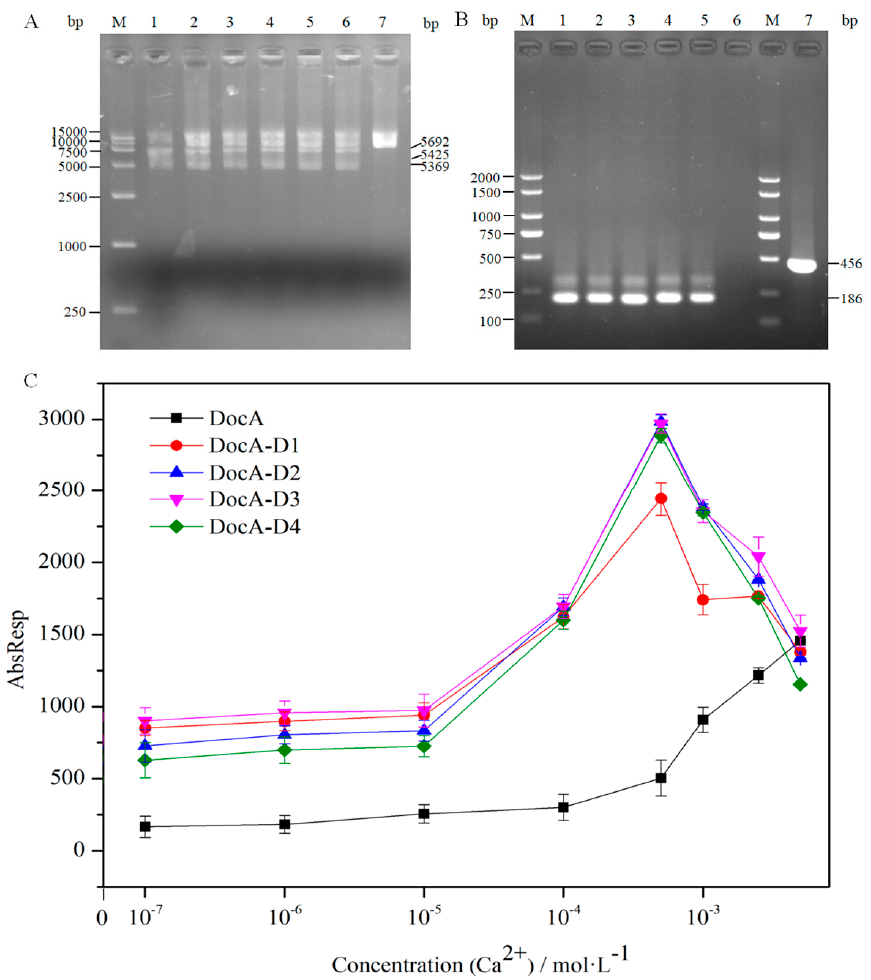
Figure 2. In vitro verification of the binding of DocA mutants to Coh. ( A ) Validation of recombinant plasmids for mutant proteins. M: marker DL15000; 1: 5369 bp DNA of pET-28a(+); 2: 5425 bp DNA of pET-28a(+)-DocA; 3: 5425 bp DNA of pET-28a(+)-DocA-D1; 4: 5425 bp DNA of pET-28a(+)-DocA-D2; 5: 5425 bp DNA of pET-28a(+)-DocA-D3; 6: 5425 bp DNA of pET-28a(+)-DocA-D4; 7: 5692 bp DNA of pET-28a(+)-Coh. ( B ) Verification of the mutant proteins engineering strains. PCR product of the mutant gene. M: marker DL2000; 1: 186 bp DNA fragment of DocA gene; 2: 186 bp DNA fragment of DocA-D1 gene; 3: 186 bp DNA fragment of DocA-D2 gene; 4: 186 bp DNA fragment of DocA-D3 gene; 5: 186 bp DNA fragment of DocA-D4 gene; 7: 456 bp DNA fragment of Coh gene. ( C ) Changes in the binding of DocA mutants and Coh under different Ca 2+ concentrations.